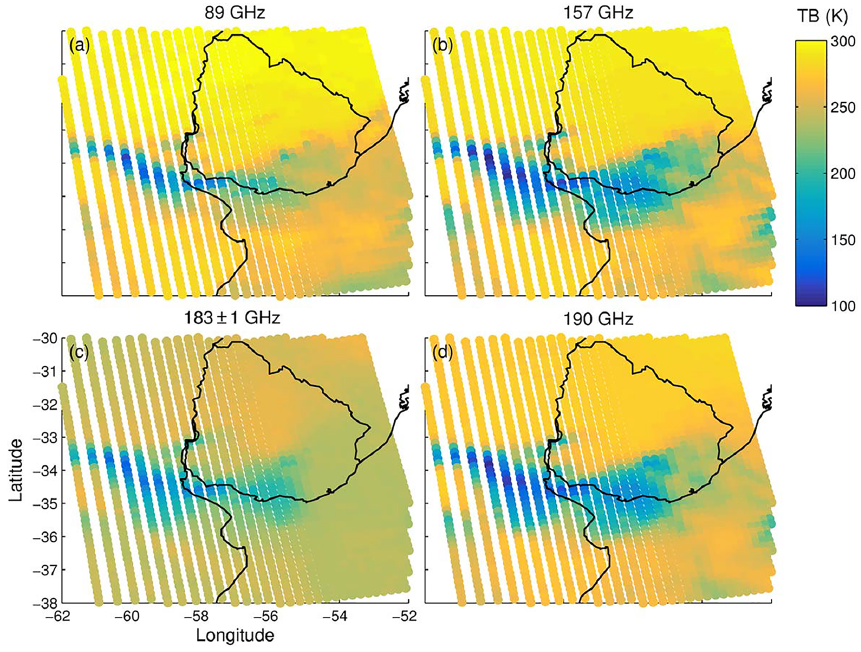
Figure 2. MHS observations on 6 December 2012 at 19:00UTC for an MCS event of interest in the present study. Note that the 183 ± 3GHz channel is not shown.